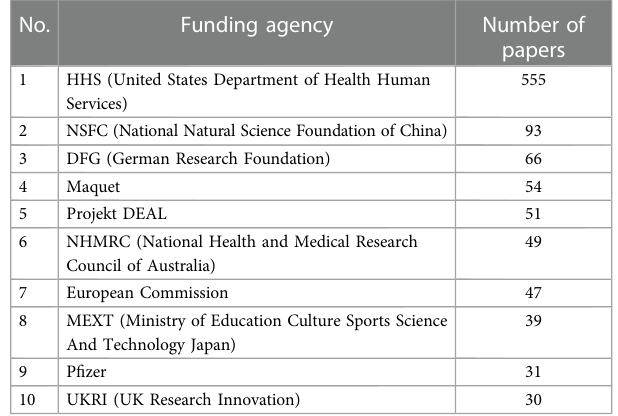
country/region. The bubble size represents the number of papers in that country/region. The connecting line between the bubbles represents the papers published in collaboration between two countries/regions. The thickness of the line indicates the number of papers in international collaboration, and the clustering to the same color indicates closer collaboration between related countries/regions. As can be seen from the fi gure, the international cooperation among countries/regions worldwide is mainly divided into the following three clusters.